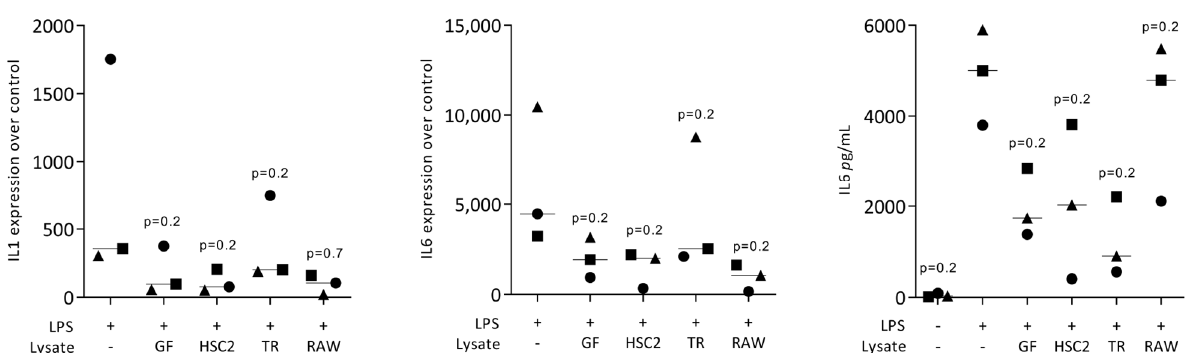
Figure 2. Freezing/thawing cell lysates reduce LPS-induced cytokine expression of RAW264.7 macrophages. RAW264.7 macrophages exposed to LPS with and without freezing/thawing cell lysates from gingival fibroblasts (GF), HSC2, TR146 (TR), and RAW264.7 (RAW) to induce the expression of IL1 and IL6 and the release of IL6 protein into the supernatant. The expression changes were normalized to unstimulated control. In the supernatant, the basal IL6 production is shown. The dots represent the three independent experiments. Statistical analysis was based on a Friedmann test and p -values are indicated.